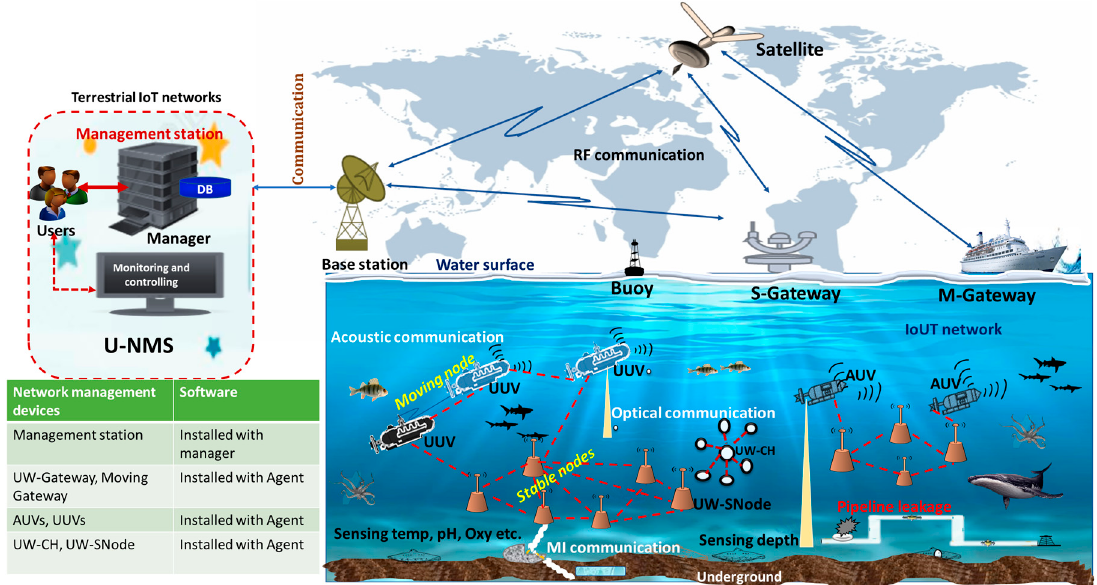
Figure 3. Conceptual architecture of underwater network management systems (U-NMS) in IoUT [79].